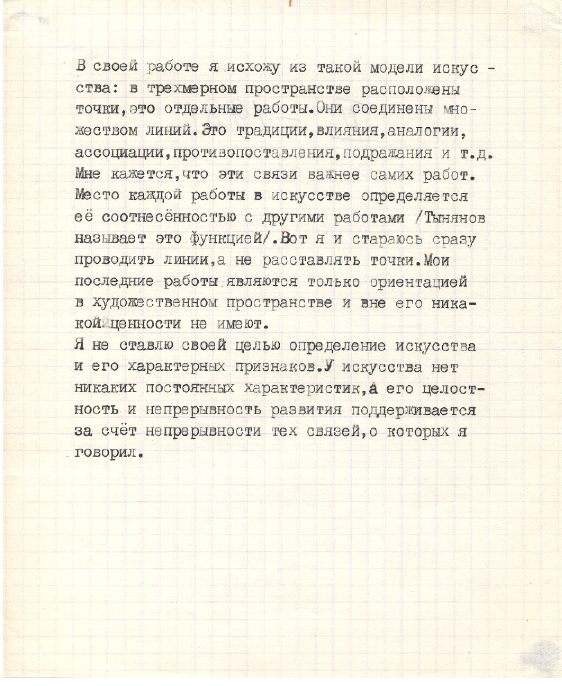
Figure 17. Albert. Autoseries II. 1981. Paper. 20.2 cm × 16.5 cm. Courtesy of the artist.